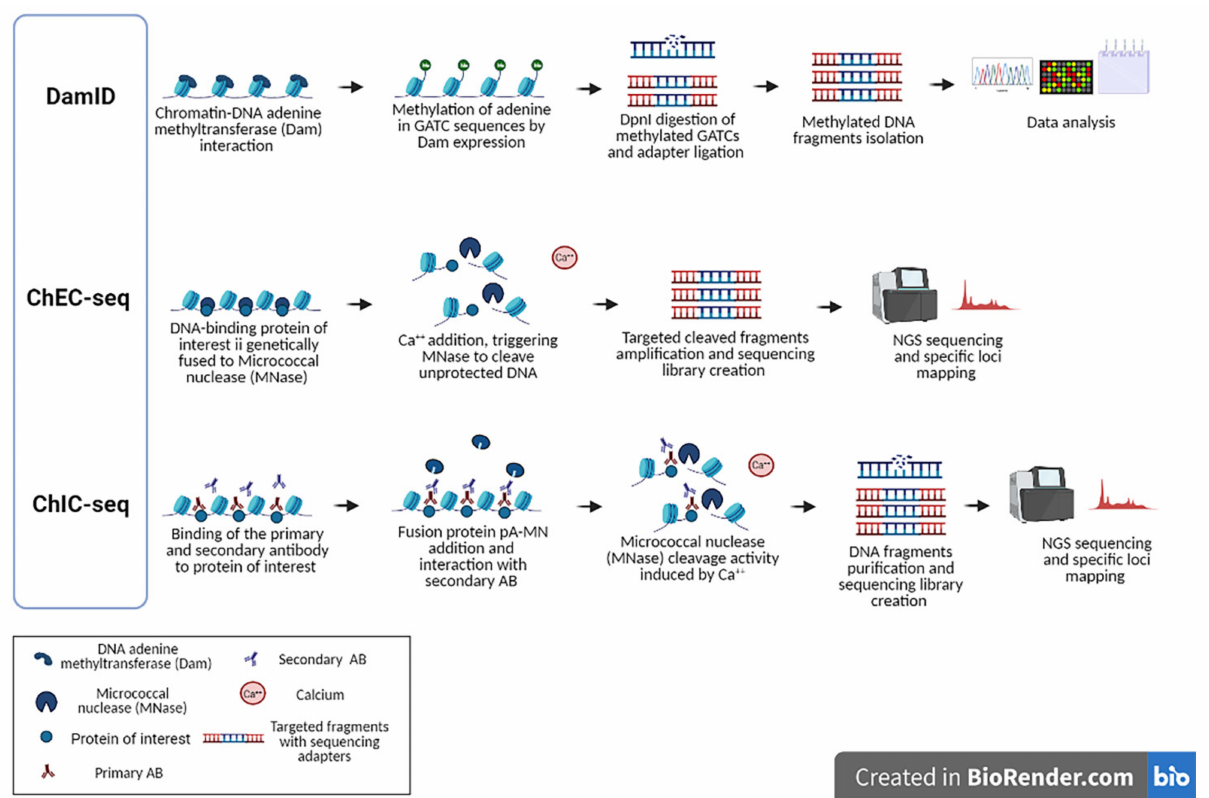
Figure 3. Enzyme-tethering analysis. DamID is used to map the binding sites of DNA and chromatin-binding proteins and consists of fusing DNA methyltransferase to a protein of interest (usually a transcription factor), which methylates adenine in GATC sequences. The genome is digested by DpnI, which cuts only methylated GATCs, that are amplified in PCR assay and subsequently analysed. In ChEC-seq analysis, Micrococcal Nuclease (MNase) cleaves DNA after Ca 2+ addition, allowing chromatin-associated protein profiling. ChIC-seq procedure is based on binding of the primary antibody (AB) to chromatin-associated protein of interest and on subsequent fusion of protein pA-MN to the secondary AB that produces DNA fragments used for sequencing library creation and data analysis (created with